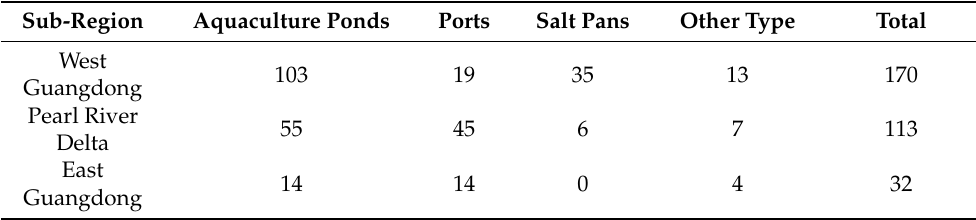
Table 6. Verification points for the three main types of reclamation in different